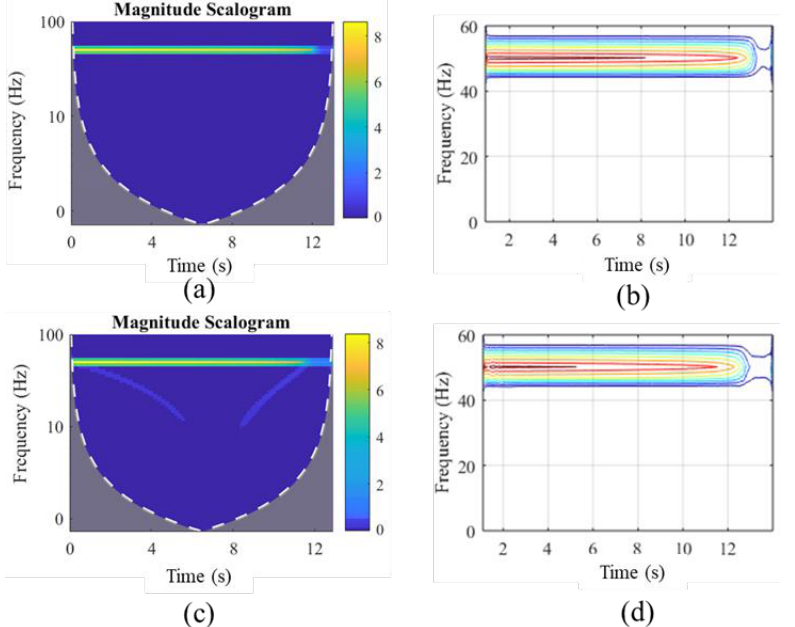
Figure 11. The results based on the measurements taken at 10% of the rated supply voltage. ( a ) The time–frequency response of the healthy motor’s phase current in the transient regime. ( b ) The respective contour plot. ( c ) The time–frequency response of the faulty motor’s phase current in the transient regime. ( d ) The respective contour plot with a 95% confidence interval.